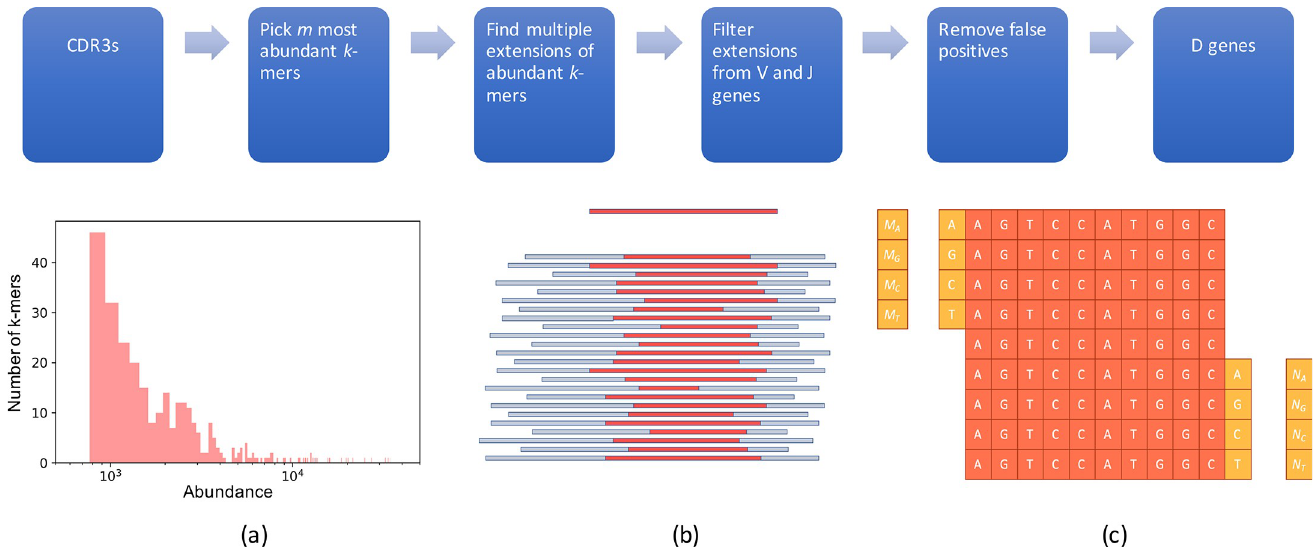
Fig 2. Outline of the MINING-D algorithm. (Top) MINING-D pipeline. (Bottom, a) Abundances of the 300 most abundant 10-mers in the MOUSE dataset vary from 770 to 34,451. (Bottom, b) A D gene (top) and its truncated substrings in various CDR3s of varying lengths (bottom). The red part of a CDR3 is the “surviving” substring of the D gene shown at the top whereas the blue part represents the non-D gene part (parts of V and J genes and random insertions). Some substrings of the original D gene, mostly central, are highly abundant. (Bottom, c) A k -mer is extended based on the relative abundances of the four shown ( k +1)-mers on the left and the four shown ( k +1)-mers on the